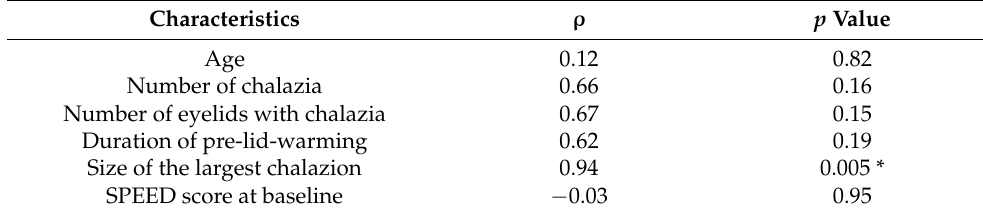
Table 4. Spearman’s correlation coefficient ( ρ ) and p values for the relation between baseline charac- teristics and the number of treatment sessions in the intense pulsed light (IPL)–meibomian gland expression (MGX) group ( n = 6).